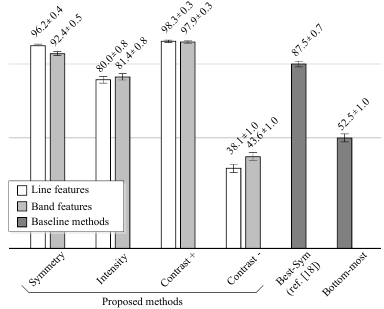
Figure 12. Comparison of lumen detection results in % of images. The proposed methods are compared to the baseline methods in noiseless images.